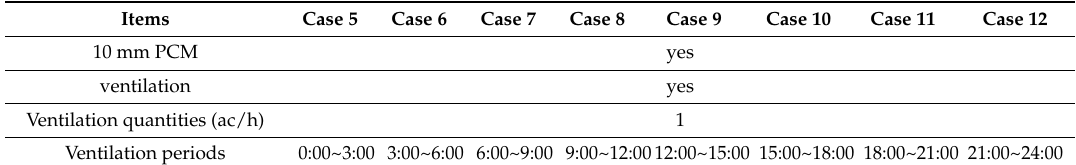
Table 4. Test cases with different PCM, ventilation quantities and ventilation